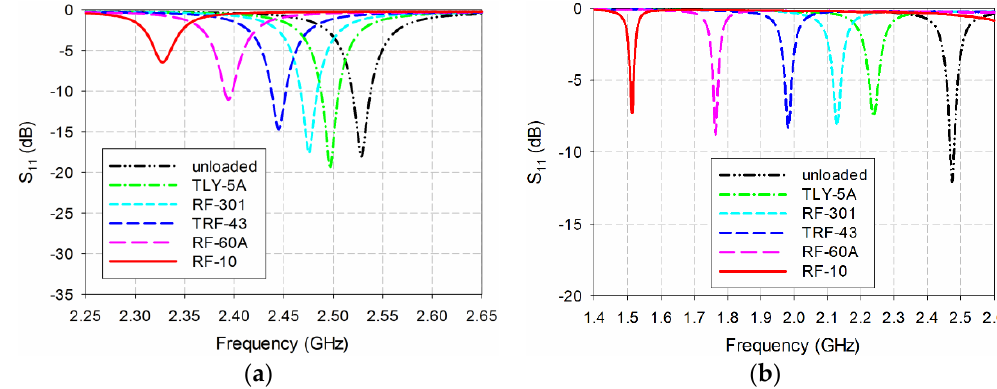
Figure 13. Measured S 11 characteristics of ( a ) the first resonant frequency of the conventional MPSA